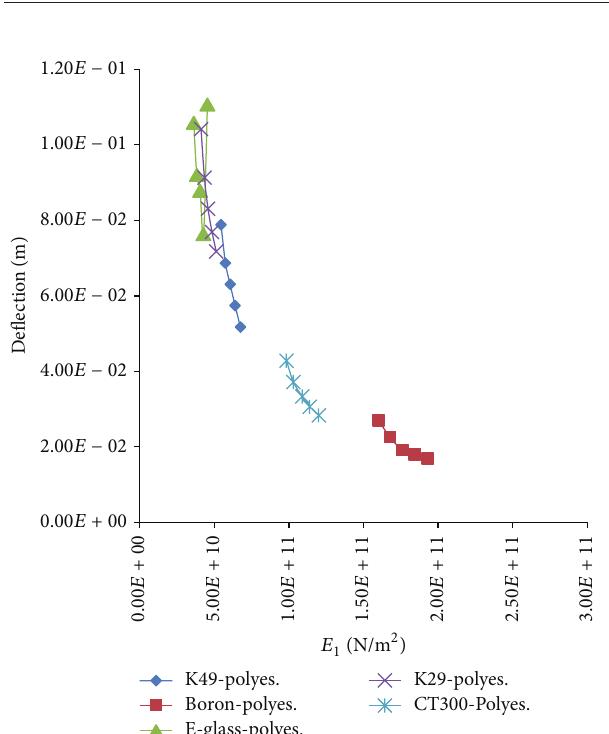
Figure 11: Effect of longitudinal modulus of elasticity on leaf spring deflection of various composite leaf springs based on matrix